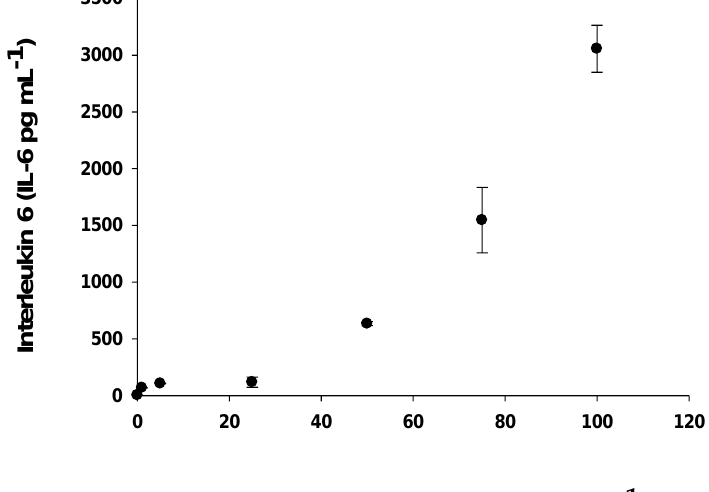
Figure 8. Production of Interleukin-6 by RAW 264.7 macrophages exposed to different concentrations of EgPs. Data points represent the average of three samples ± SD.